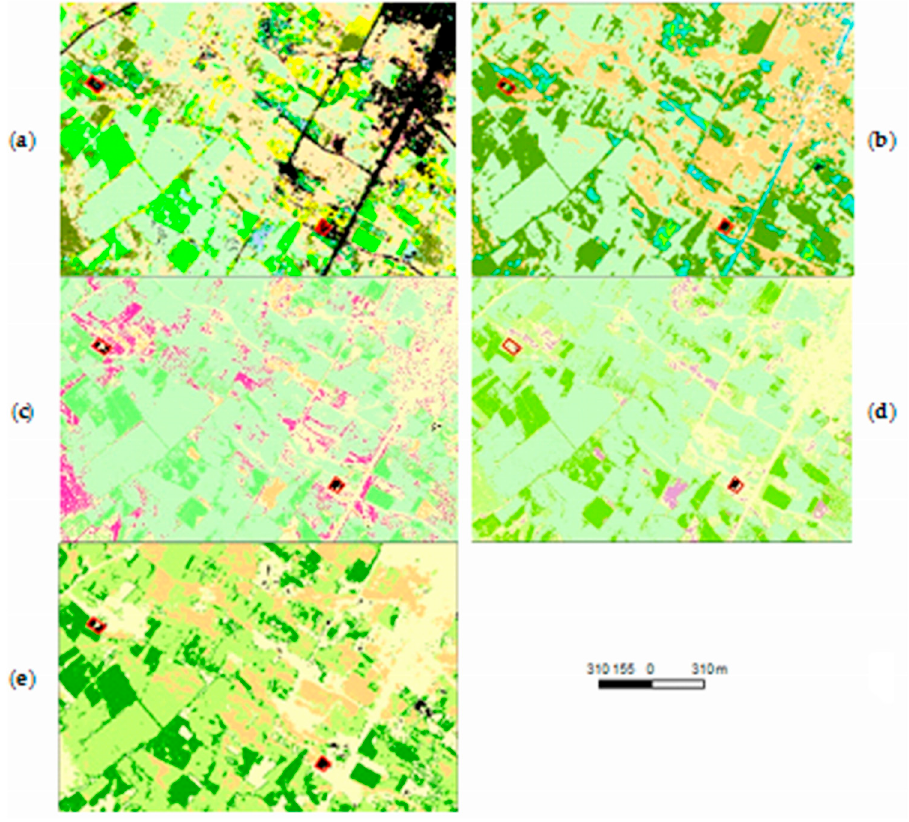
Figure 12. SVM classification for Tunisian study areas; ( a ): SVM classification using Sentinel-2 RGB image in February, ( b ): SVM classification using Sentinel-2 Composite 3 in February, ( c ): SVM classification using PlanetScope RGB image in February, ( d ): SVM classification using PlanetScope Composite 3 in February, ( e ): SVM classification using Sentinel-2 Composite 1 image in February. OMW disposal areas are indicated inside the red frame.